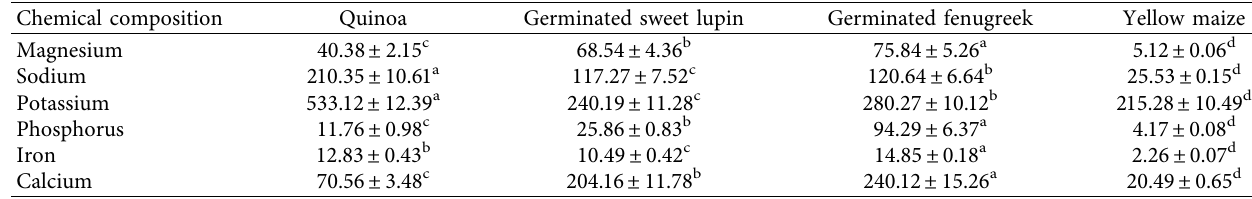
Table 3: Minerals content (mg/100 g DW) of raw